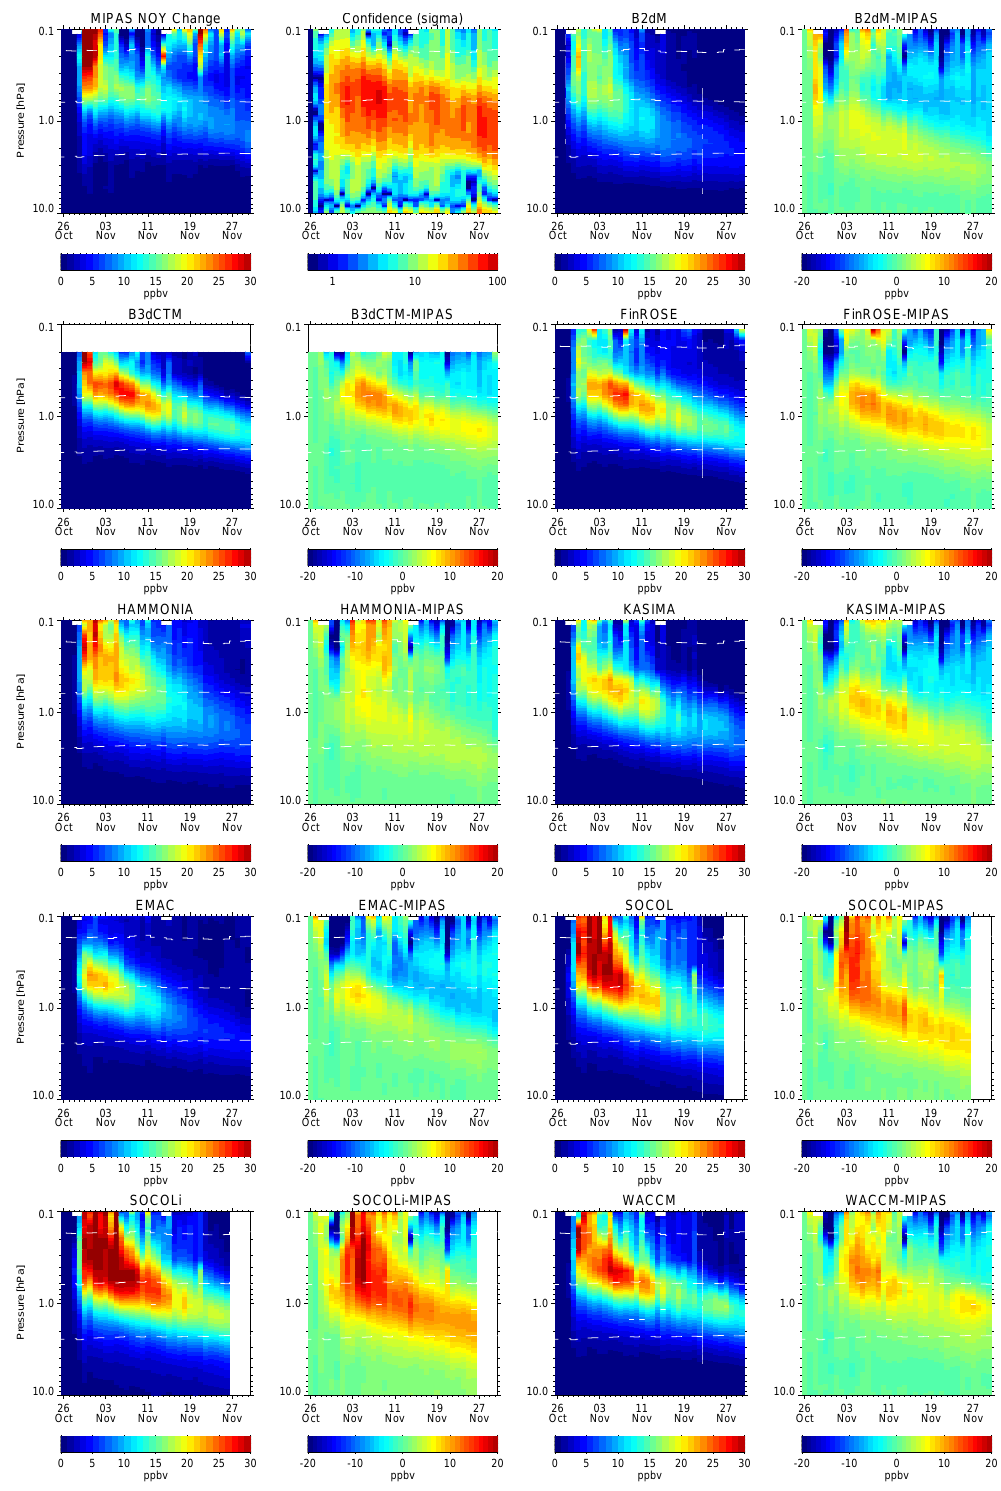
Fig. 15. Temporal evolution of area-weighted averages of NO y changes with respect to 26 October 2003 in MIPAS observations and model simulations at 40–90 ◦ N, as well as differences between modeled and observed averages. The significance of observed NO y changes (in units of σ ) is shown in the upper second panel (from the left). Note that observations exhibiting CO abundances higher than 1ppmv have been omitted in the averaging in order to exclude the contributions from descended NO x produced by EEP at higher altitudes before the Halloween stroms. See text for further details.